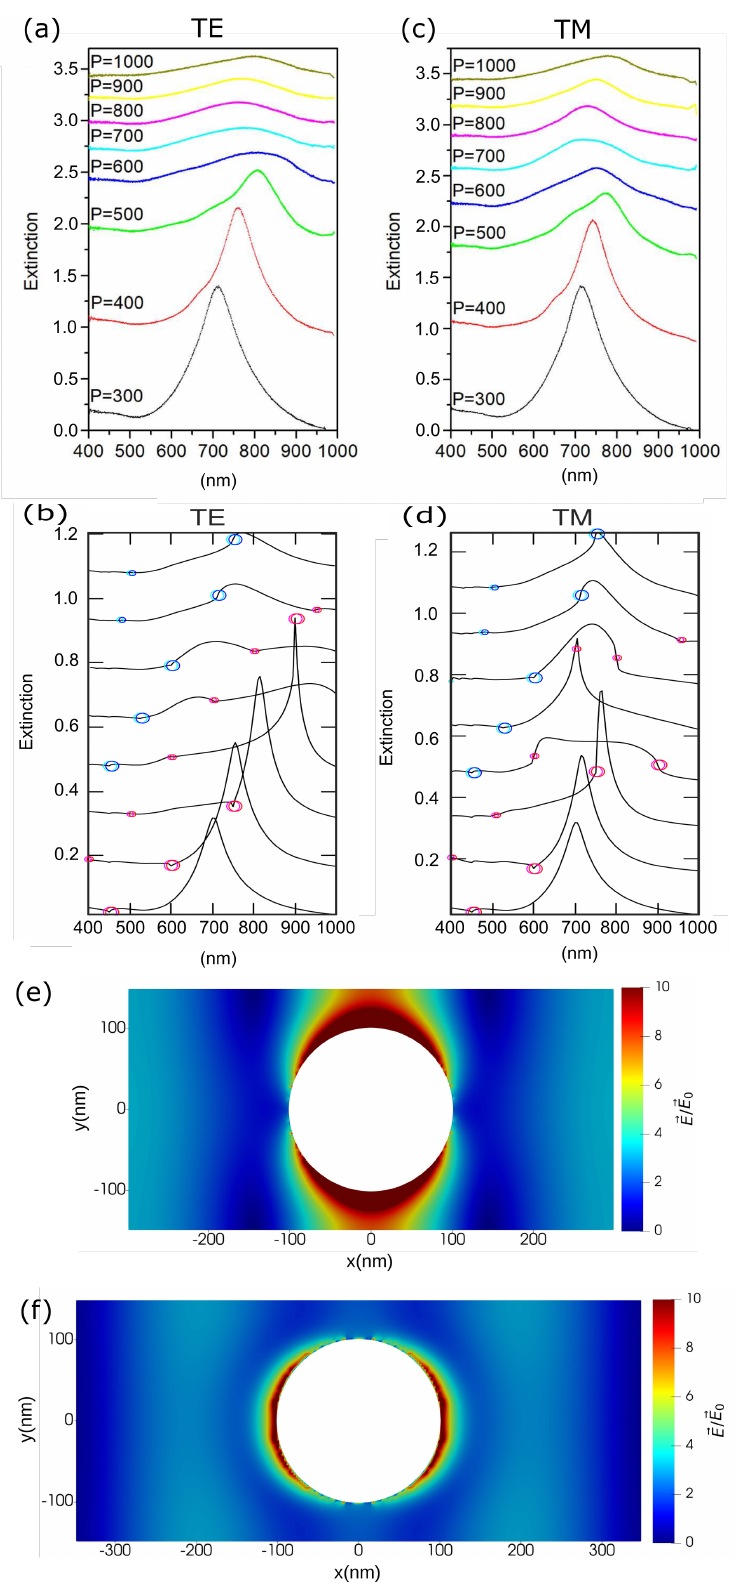
Figure 3. Experimental ( top ) and numerical ( bottom ) extinction spectra at normal incidence on grat- ings with Py = 300 nm and Px varying from 300 to 1000 nm, for TE ( a , b ) and TM ( c , d ) polarization. Electric field distribution calculated 5 nm above the glass substrate for ( e ) Px = 600 nm, wavelength of 900 nm with TE polarization ( f ) for Px = 700 nm, wavelength of 700 nm with TM